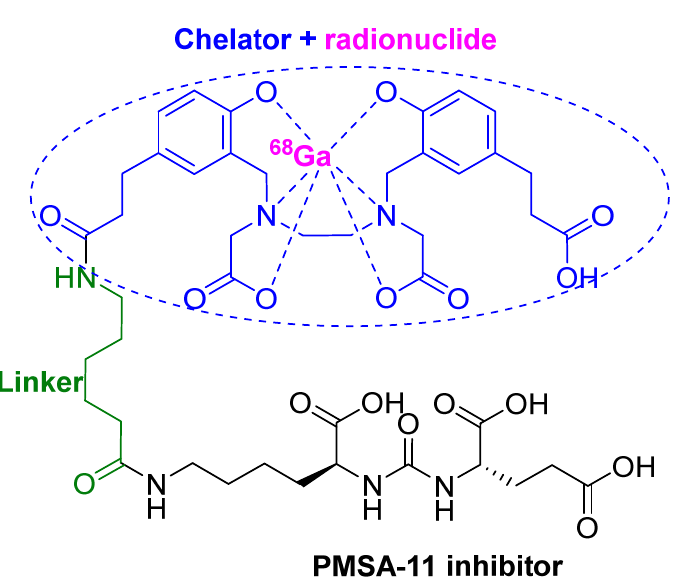
Figure 6. Chemical structure of 68 Ga ‐ PMSA ‐ 11. 68 Ga ‐ PSMA ‐ 11 is indicated for PET imaging of prostate ‐ specific membrane antigen